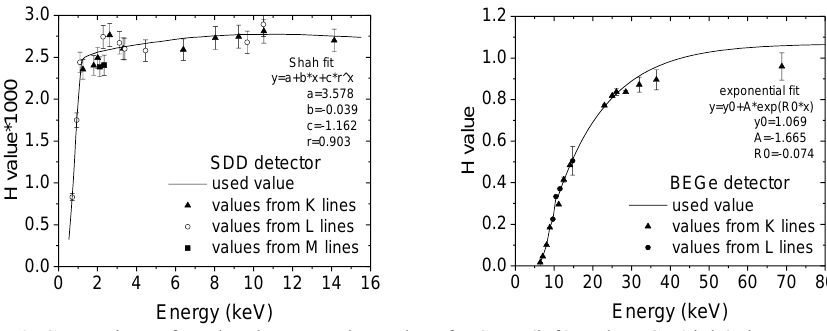
Fig. 2. Comparison of used and measured H-values for SDD (left) and BEGe (right) detectors. To validate the H-value calibration of both detectors, the prepared thick samples of IAEA reference materials were measured in the same geometry. Elemental composition of samples was used for calculation of attenuation coefficient of each reference sample in